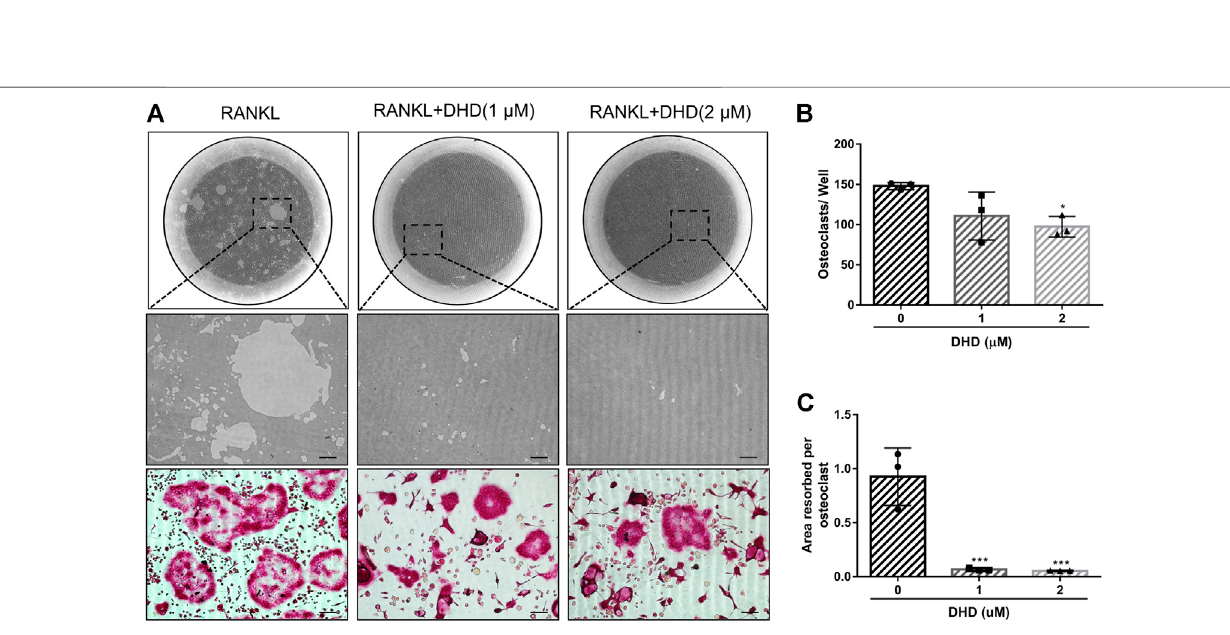
Frontiers in Pharmacology |